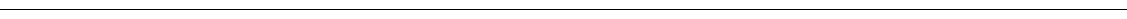
Fig. 6 DEK is a bona fi de CELF1 target. a CELF1 and DEK expression levels in indicated melanoma cell lines, detected by protein immnoblotting. b Immunoblots of the indicated cell populations to con fi rm DEK downregulation upon CELF1 depletion, for two shRNAs (blue) or CRISPR/Cas9 system (red). c Staining of colonies formed in the indicated cell populations transduced with full length DEK (or an empty GFP plasmid) and infected with control or shCELF1-1. d Quanti fi cation of data in c . Green bars represent the number of colonies of GFP vs. DEK in basal conditions. Those in the presence or absence of shCELF1 are shown in blue. Error bars correspond to SEM of three experiments. e Schematic representation of full length DEK and the GFP-tagged mutants to assess the impact of the DNA binding domain in the rescue of CELF1-depletion defects. f Expression levels of the different DEK constructs visualized with antibodies against GFP or the DEK central domain. g Differential impact of full length DEK vs. mutants to compensate for the inhibitory effect of CELF1 depletion. Data correspond to mRNA expression by qPCR represented relative to GFP or indicated DEK constructs infected CELF1-depleted cells. Error bars correspond to SEM of three independent experiments in triplicate. h CELF1 immunoprecipitation for subsequent qPCR-based validation of binding to DEK 3 ′ UTR, as quanti fi ed in i . Error bars correspond to SEM of two experiments. j Upper, histogram of RIP-Seq peak calling from identifying CELF1 binding enrichment at the 3 ′ UTR of the DEK mRNA, relative to input controls. Bottom panel, DEK 3 ′ UTR fragments cloned into lentiviral vectors to de fi ne CELF1 recognition. GREs are labeled in red. k Ampli fi cation of DEK 3 ′ UTR fragments after CELF1 RNA-IP, determined by semiqRT-PCR. l Protein depletion ef fi ciency of shCELF1-1 shown by protein immunoblots compared to shControl induced UACC-62 cells. m DEK mRNA levels after actinomycin D treatment in indicated UACC-62 populations expressed as a function of time. Error bars correspond to SEM of three experiments in triplicate. n Transduction of UACC-62 melanoma cells with GFP or GFP-DEK cDNA (i.e., lacking 3 ′ UTR) for subsequent transduction of control or CELF1 shRNA, followed by protein